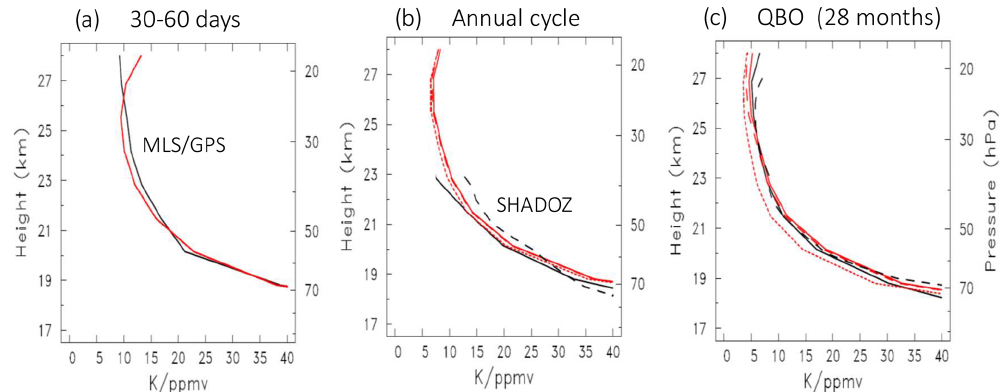
Figure 9. Vertical profiles of ( T σ /X σ ) amplitude for selected frequency bands: (a) 30–60d periods, (b) the annual cycle (12-month period) and (c) the QBO period ( ∼ 28 months). The solid black lines are results from MLS and GPS satellite data, and the red lines show idealized model calculations (the solid red line includes ozone damping, dashed red lines are for δ = 0 and dotted red lines are for β = 0). Additionally, results from SHADOZ ozone and temperature data are included as dashed black lines in (b–c) , as described in text. Observations for the annual cycle (b) are only shown over altitudes 19–23km where the annual cycle is relatively large and